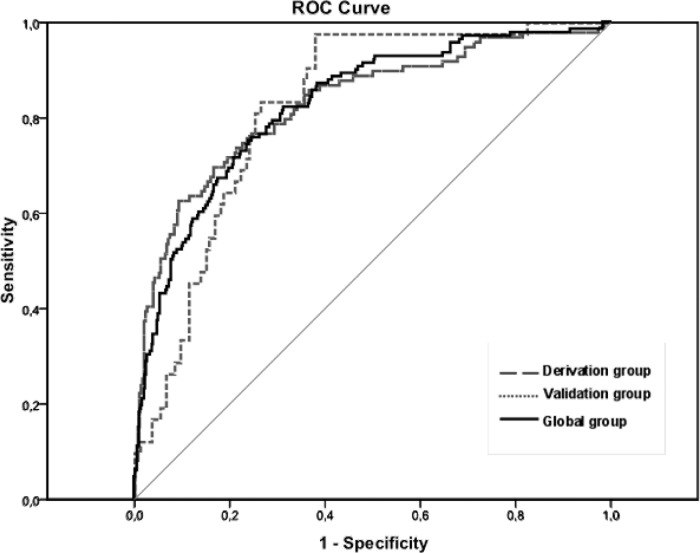
AUROC curve analysis for RRVR, including the overall
cohort (0.82; p<0.001), the estimation cohort (0.83;
p<0.001) and the validation cohort (0.82; p<0.001)